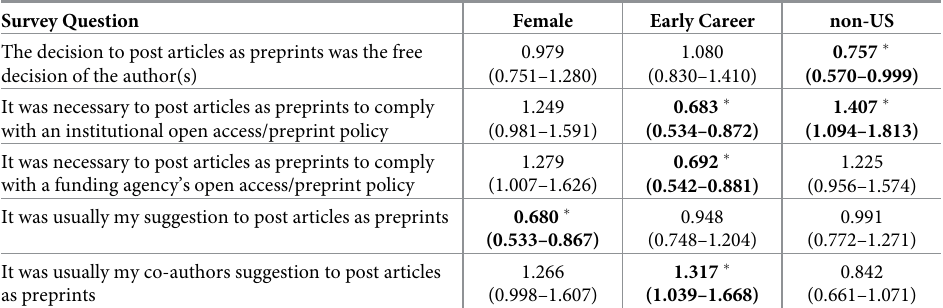
Table 1. Results of ordinal logistic regression for survey questions in Fig 4 (corresponding authorships only; N = 1146). Values are presented as exponentiated odds-ratios, with the range in parentheses representing 95% confi- dence intervals. Significant results at the 95% level are indicated in bold and with “ �